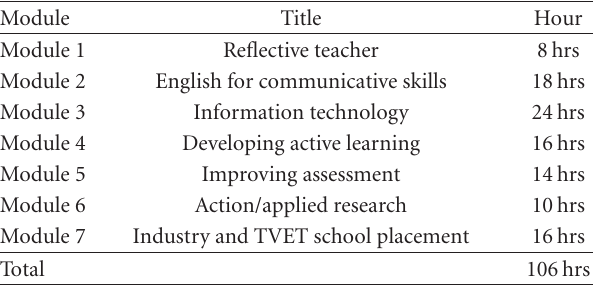
Table 1: Professional development training modules at Adama